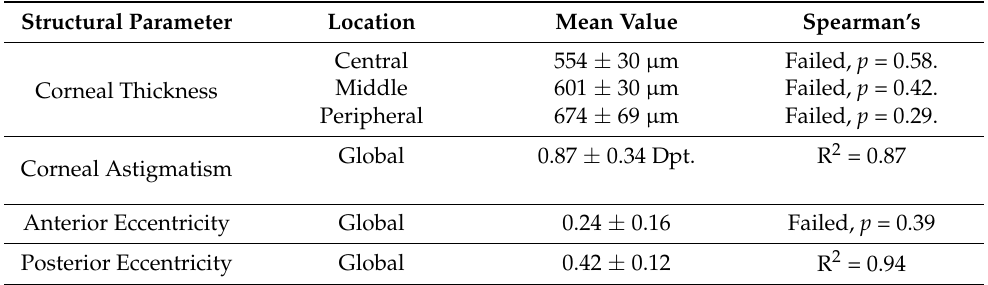
Table 4. Mean values of geometrical parameters and correlation results with OTI